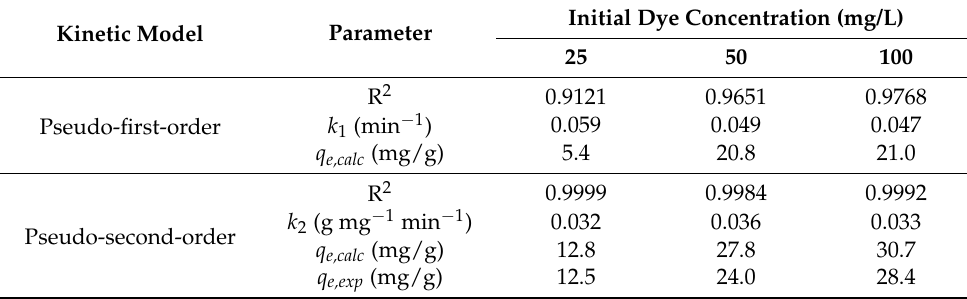
Figure 9. ( a ) Pseudo-first-order and ( b ) pseudo-second-order kinetics for the adsorption of dyes onto the banana peel. Table 2. Adsorption kinetic parameters for dye adsorption onto the banana